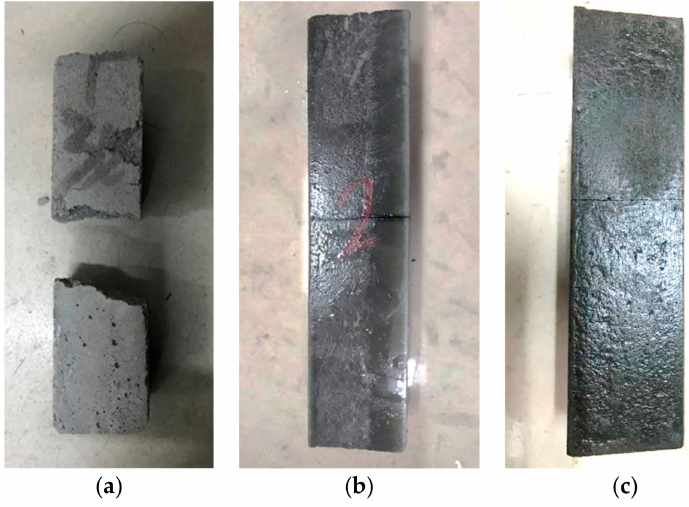
Figure 9. Failure modes of specimens with di ff erent ECC fiber dosages. ( a ) 0% Dosage; ( b ) 1% Dosage; ( c ) 2%